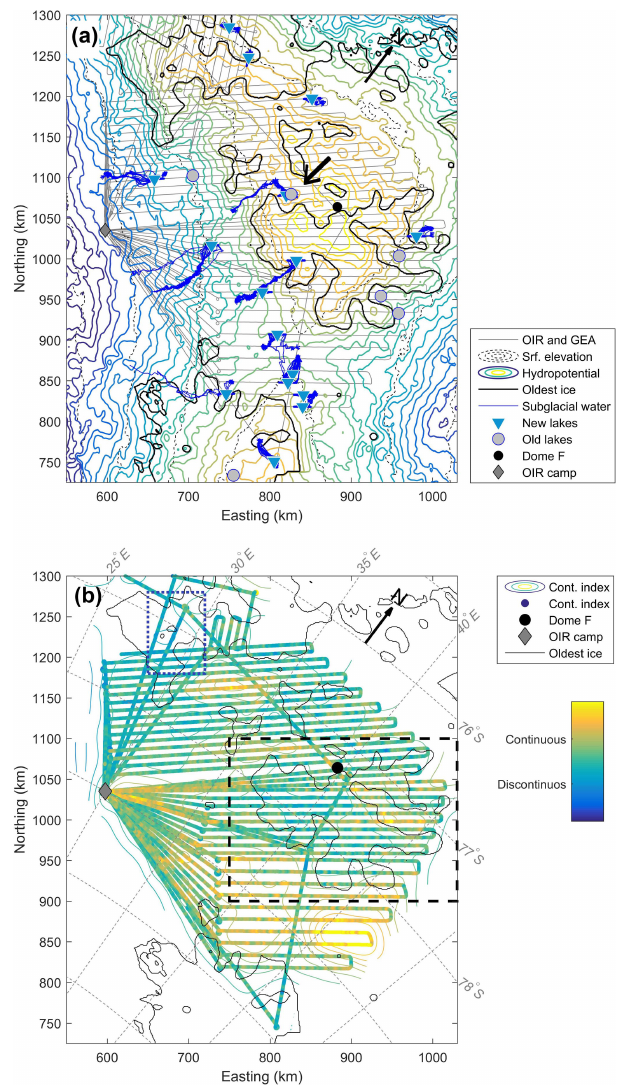
Figure 6. (a) The hydropotential (coloured contours) with the new Oldest Ice prediction outlined in black. The identified lakes are shown with triangles and the drainage routes of the water with blue lines. Grey circles indicate lakes identified in earlier studies (Siegert et al., 2005; Fujita et al., 2012). The black arrow indicates the loca- tion of Fig. 5. (b) Continuity index of the internal layers in the OIR radar data. The index has been smoothed with a horizontal window of 100 samples ( ∼ 3.5km). Here, yellow colours indicate the high- est layer continuity. The dashed box shows the location of Fig.